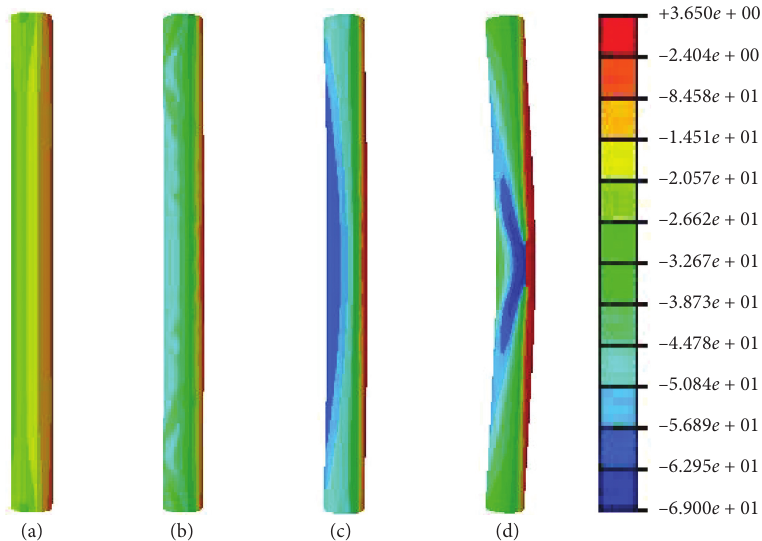
Figure 17: The longitudinal stress contour maps of the concrete. (a) Point A. (b) Point B. (c) Point C. (d) Point